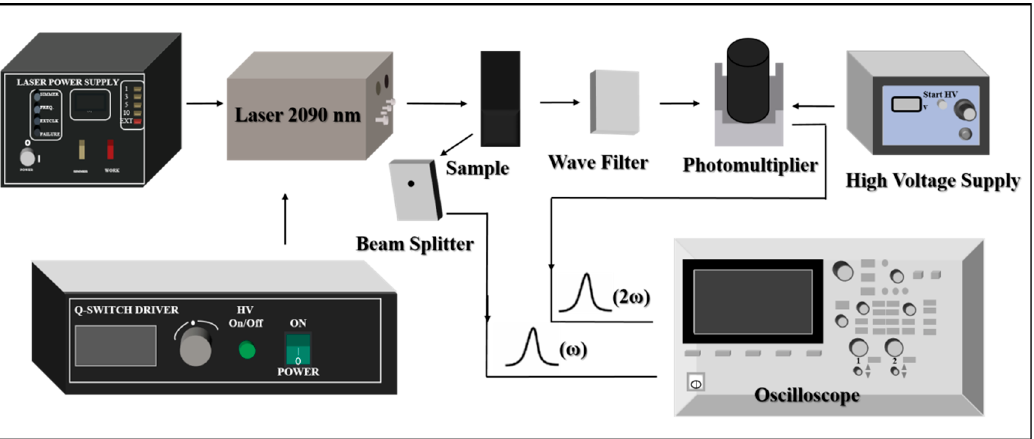
Figure 3. Apparatus utilized for measurement of second-harmonic generation in powders.